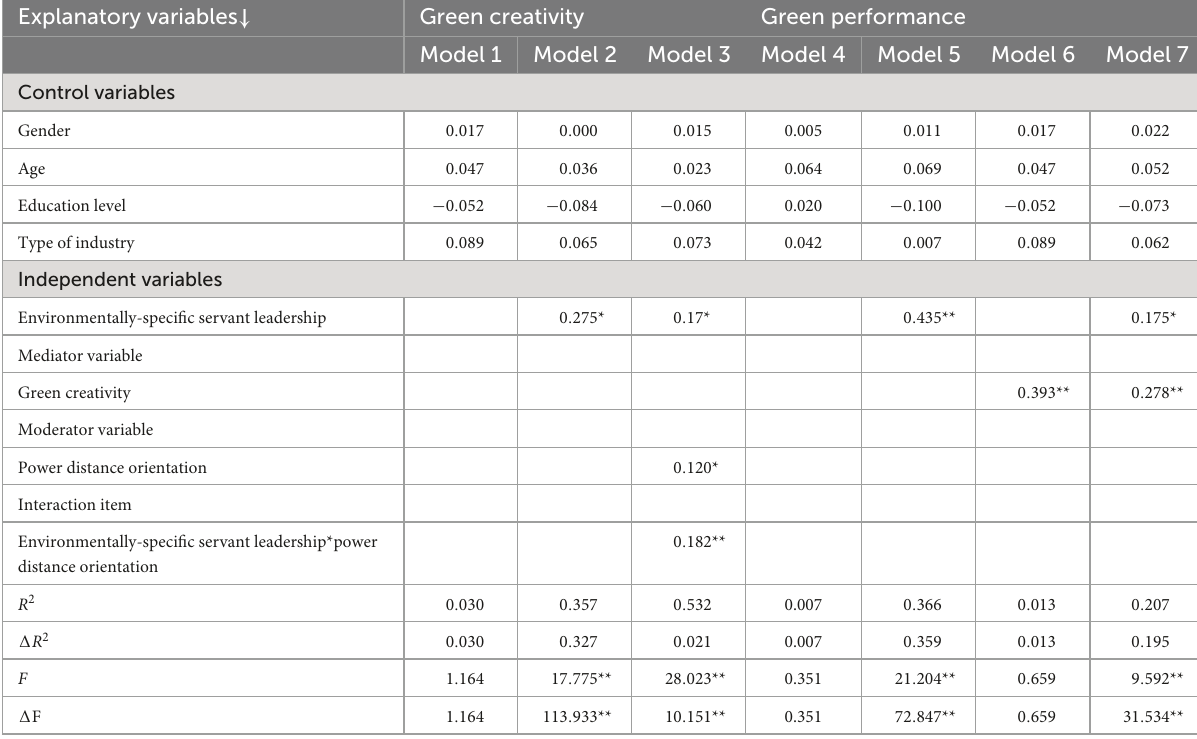
TABLE 5 Regression results for directing, mediating, and moderating